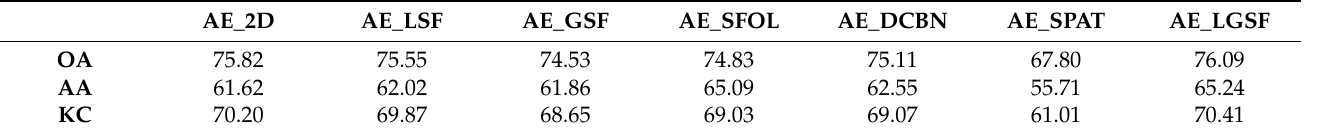
Table 11. Classification results of ablation experiments on the Houston 2018 dataset. (shown in %).